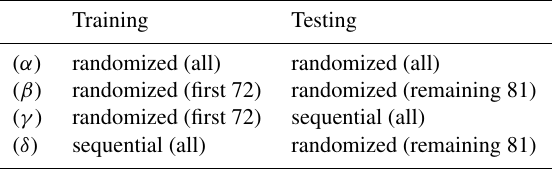
Table 4. Combinations of training including hyperparameter opti- mization and testing datasets for a comparison between randomized and sequential calibration methods for the reduced